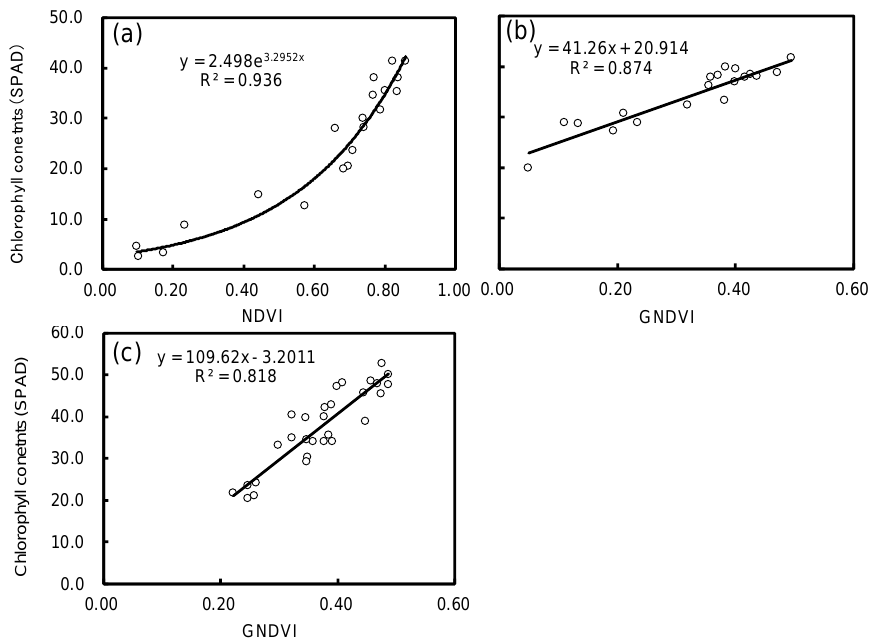
Figure 3. Relationships between VI (Vegetation Index) and SPAD values in each of the samples. (a) Sample A, (b) Sample B, and (c) Sample C. NDVI: Normalized difference vegetation index, GNDVI: Green normalized difference vegetation index.